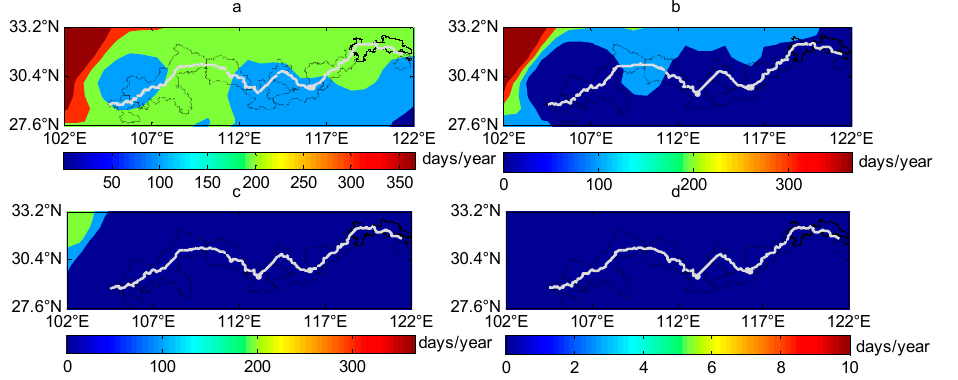
8 of 15 Figure 5. Time series of area ‐ averages heat wave indices ( TXx , TR , and WSDI , and the gray area indicates a more significant variability) during the period 1979–2017 based on GHCNDEX data. 3.3. Cold Spell According to the spatial distribution of cold spell weather (Figure 6), except for the Jinsha River area where the source of the Yangtze River originated, there is no cold spell weather across the YRIW, and it is less likely to occur and occasionally occurs, which shows a slight risk to IWT. Three extreme weather indices were selected relating to low temperatures in the ETCCDI index. The minimum of TN ( TNn ) represents the coldest day of a year, and TN presents a daily minimum near surface temperatures. Frost days ( FD ) counts the days when TN is below 0 °C. The Cold Spell Duration Indices ( CSDI ) counts the number of days in a year when TN is above the 90th percentile for six consecutive days or longer. There was a significant trend observed using the Mann–Kendall test